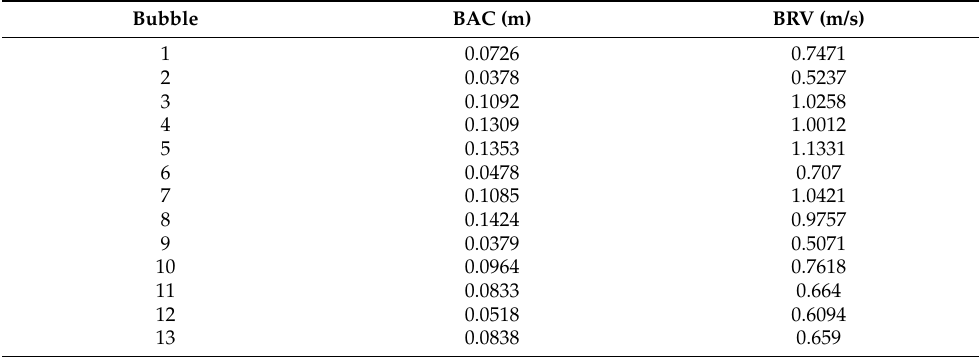
Table 5. Identification number for each bubble reported in Figure 14, along with size and velocity of each bubble.